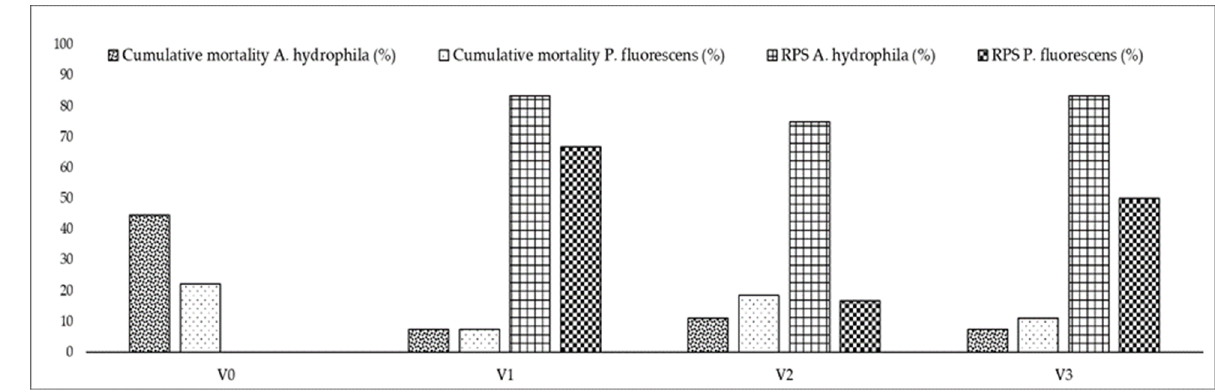
Figure 3. Daily cumulative mortality (%) of O. niloticus during the post-challenge test with P. fluorescens. At the end of the challenge test, the cumulative mortality was higher in the control group, both in fish injected with A. hydrophila and P. fluorescens , followed by the variant V 2 . The relative percent survival (RPS) was similar in the case of V 1 (81.33%) and V 3 (81.33%), followed by the V 2 variant (75%) for fish injected with A. hydrophila . For P. fluorescens , the RPS was the highest in V 1 (66.66%) and V 3 (50%) (Figure 4).